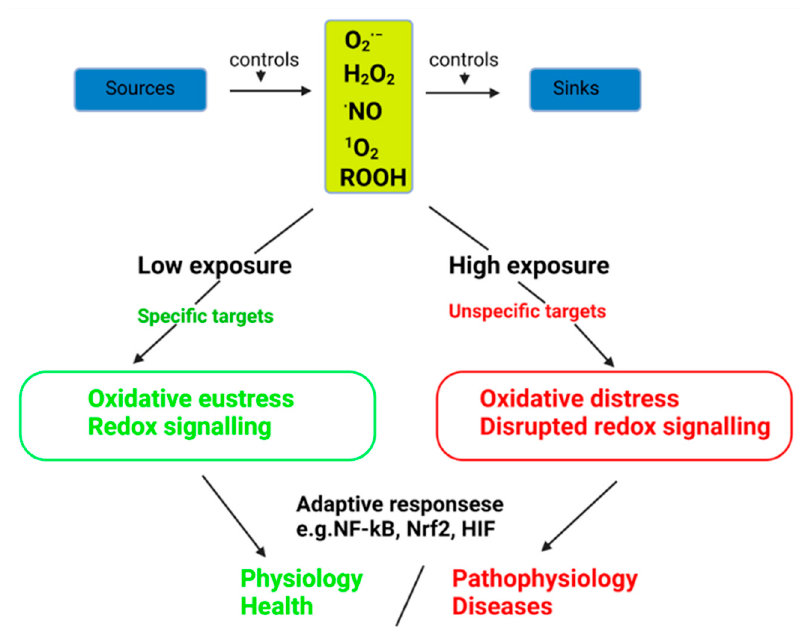
Figure 4. Oxidative stress and its relationship to redox signaling. Endogenous or exogenous sources produce different oxidants. The removal reactions (sinks) also control normal levels of oxidants. Low oxidants exposure induces redox changes in the specific targets leading to redox signaling (oxidative eustress), whereas high exposure leads to disturbed redox signaling and/or damage to biomolecules (oxidative distress). Adaptive responses modulate and counteract these pathways. Depending on the outcome, it contributes either to health or disease progression. O 2 · − , superoxide anion radical; H 2 O 2 , hydrogen peroxide; ROOH, organic hydroperoxides; ·NO, nitric oxide; 1 O 2 , singlet molecular oxygen; Nrf2, nuclear factor erythroid 2–related factor 2; HIF, hy- poxia-inducible factor. The figure is redrawn with Biorender from reference [26] with permission (License Number 5484750226313). Copyright © 2019 Elsevier Inc.